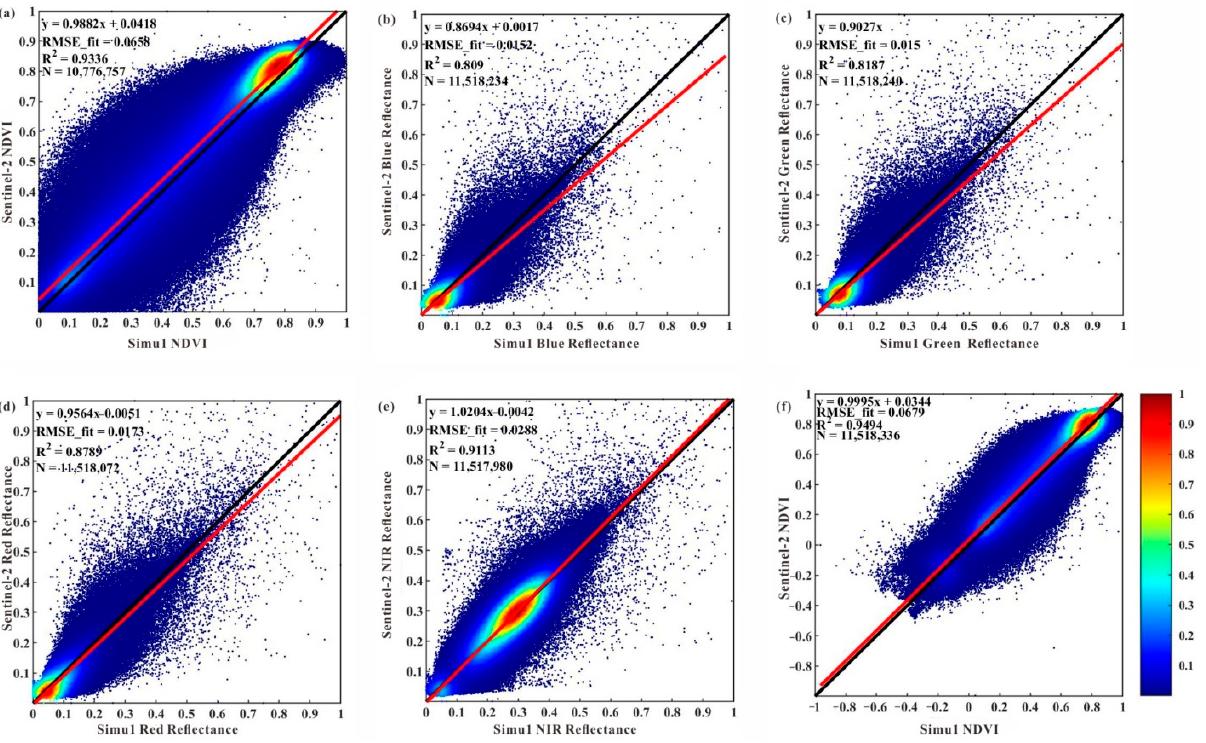
Figure 11. Scatter plot of the actually acquired and reconstructed image in Case 1 situation in Area B (28 April 2020). ( a ) NDVI in the range of [0–1]; ( b – e ) surface reflectance in blue, green, red and NIR band, respectively; ( f ) NDVI in the range of [ − 1–1]).